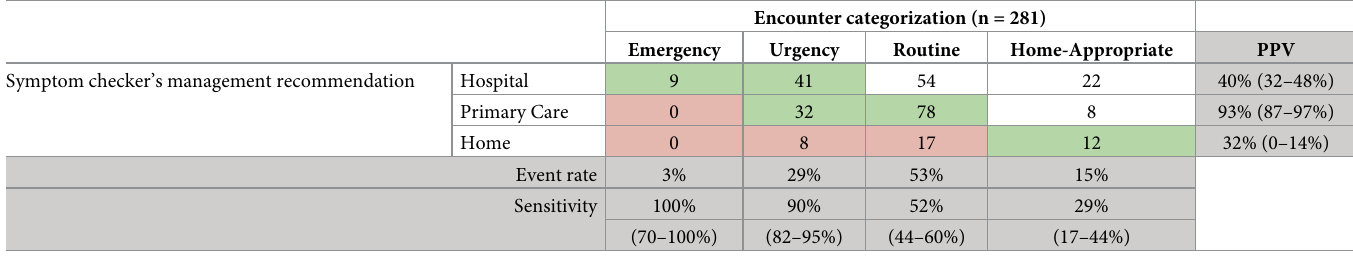
Green colored cells represent accurate triage recommendations made by the symptom checker. Red colored and uncolored cells represent under-triage and over-triage, respectively. Sensitivity and positive predictive value (PPV) are reported with 95% confidence